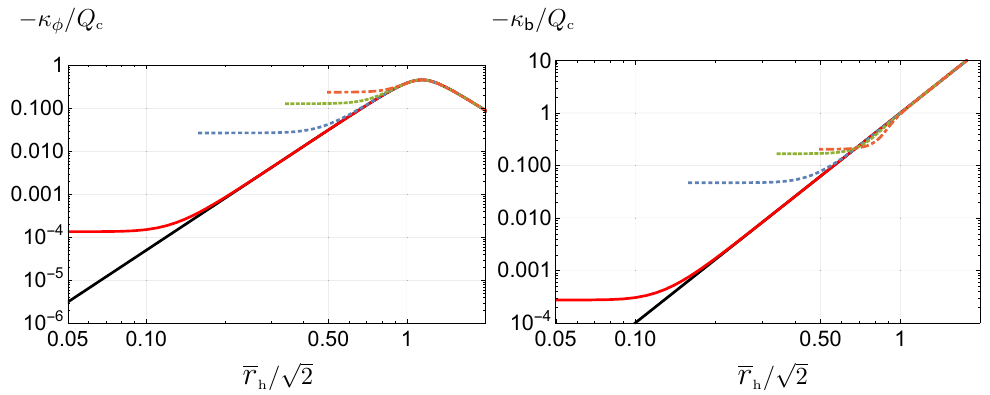
Figure 9 . UV coefficients κ